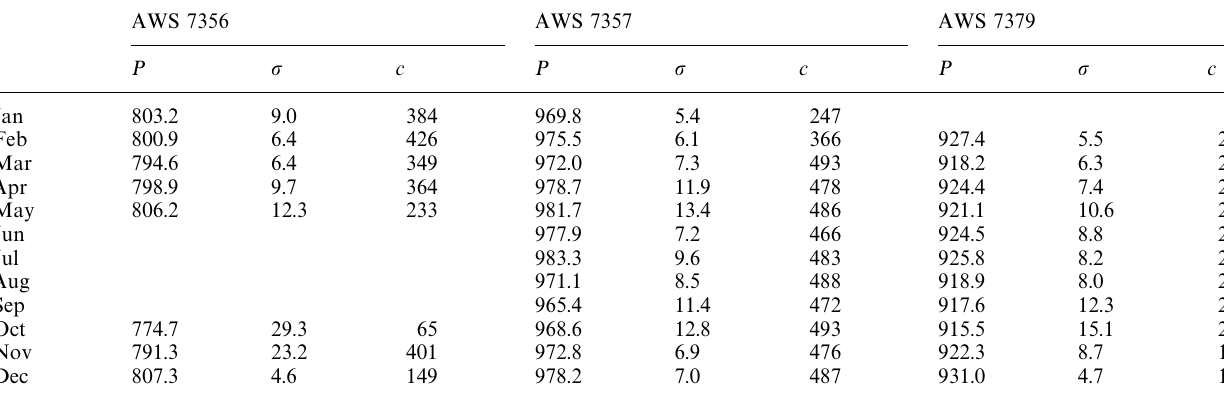
Table 4. Monthly average wind speed (ms (cid:126)(cid:49) ), standard deviation and number of cases at all AWS